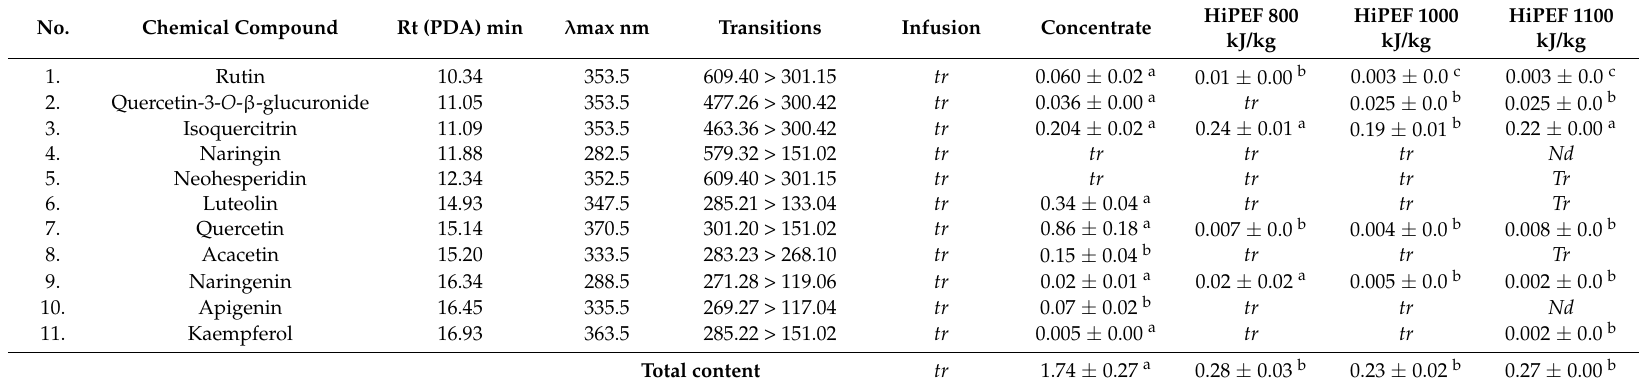
Data Mean ± SD, different letters in same raw indicate statistical differences ( p < 0.05). tr indicates trace; Nd , not